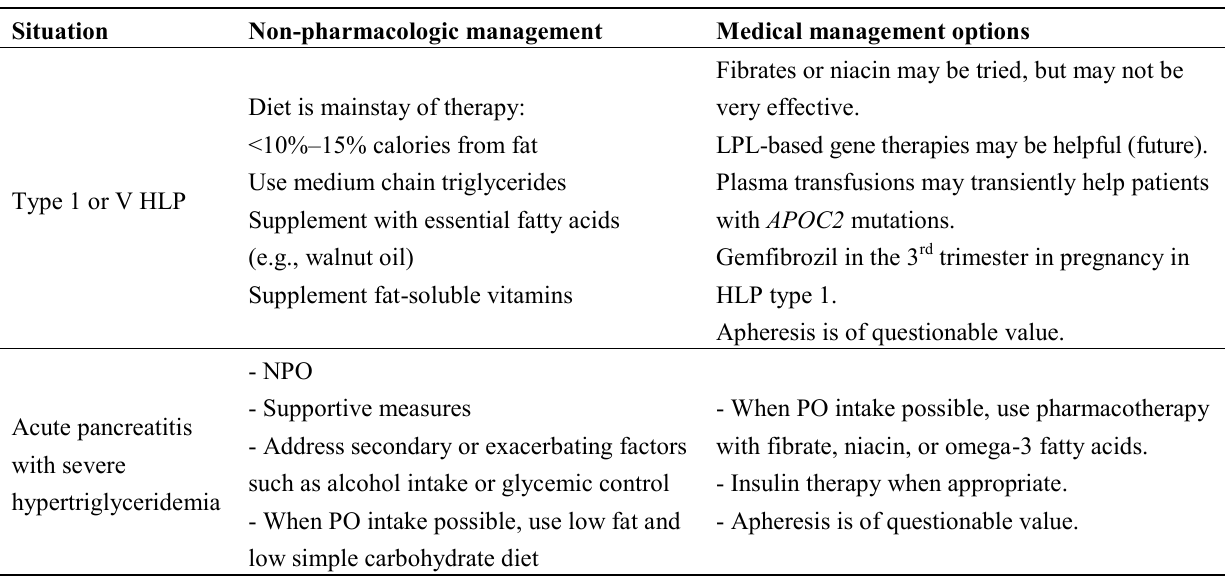
Table 6. Managing hypertriglyceridemia in special